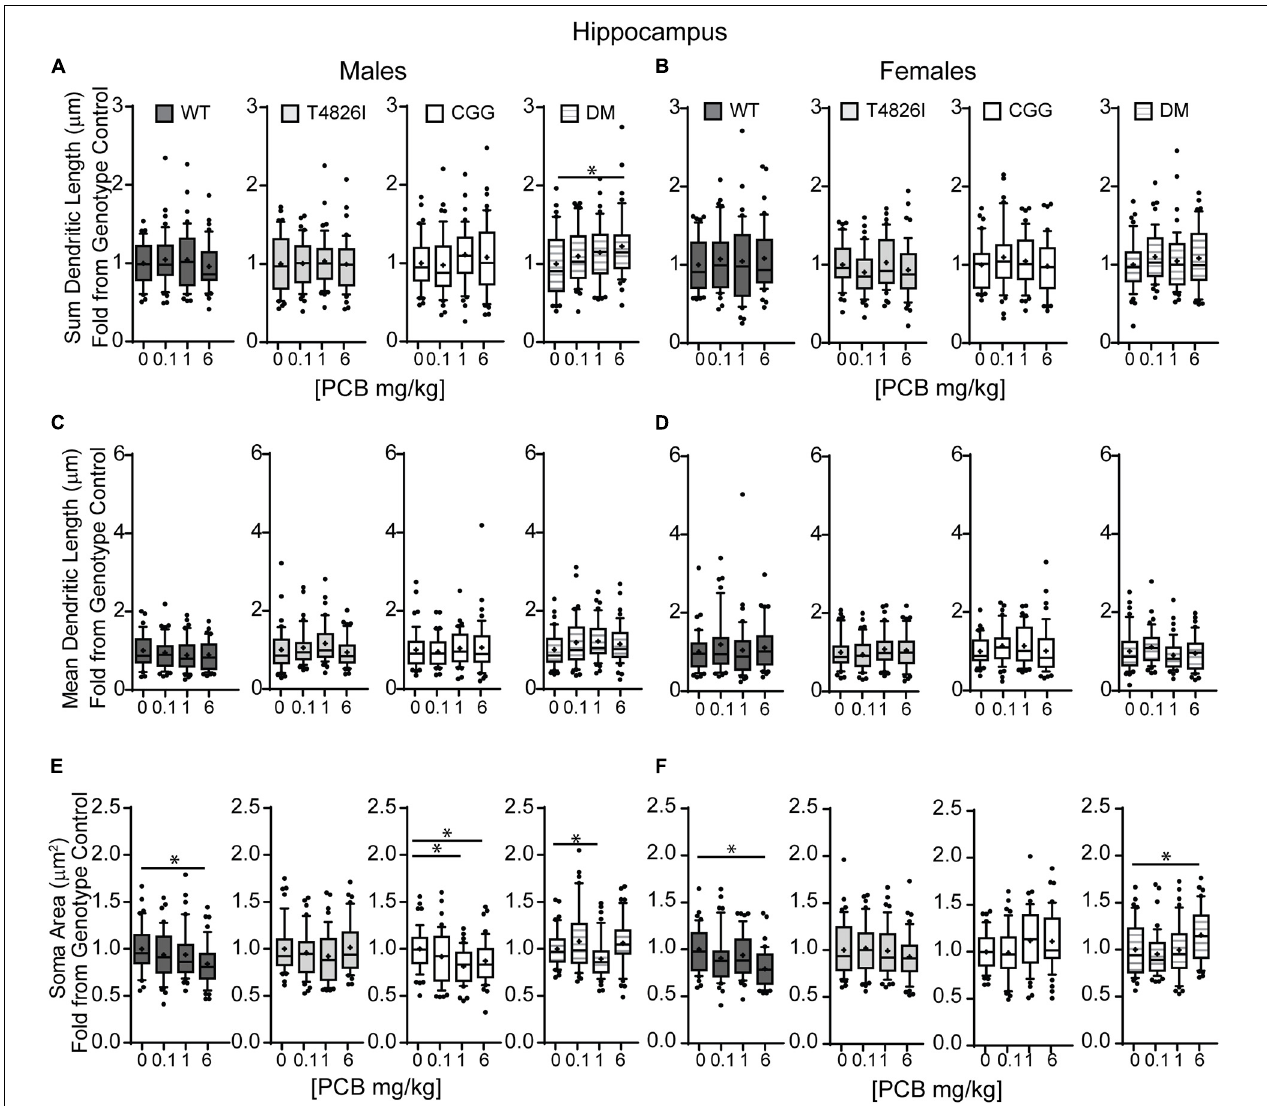
FIGURE 3 | Polychlorinated biphenyls effects on dendritic sum length are observed in DM male but not female mice and both genotype and PCB exposure impact soma area in both sexes. Dendritic morphology was assessed in basilar dendritic arbors of Golgi-stained pyramidal CA1 hippocampal neurons in P27–31 male and female WT, T4826I, CGG, or DM mice following gestational and lactational PCB exposure via the maternal diet. (A,B) Sum length of dendrites per neuron ( µ m). (C,D) Mean dendritic length per neuron ( µ m). (E,F) Cell body area per neuron ( µ m 2 ). Data ( N = 39–49 neurons from at least six independent mice per sex per genotype per dose) are presented as box plots, where the box indicates the lower (25th) to upper (75th) quartiles, the “+” indicates the mean, whiskers indicate the 10–90th percentile, and dots represent values outside the upper or lower fences. Bar and asterisk indicate a significant difference between groups as determined by Kruskal–Wallis test followed by Dunn’s multiple comparisons test, or (E-CGG) one-way ANOVA followed by Dunnett’s multiple comparisons test with p ≤ 0.05 considered statistically significant. Average values of vehicle controls for WT, T4826I, CGG, and DM, respectively, are (A) 898.8, 804.8, 833.2, 815.2 µ m; (B) 833.1, 903.0, 909.5, 801.5 µ m; (C) 256.4, 215.7, 236.5, 228.3 µ m; (D) 214.4, 244.9, 241.9, 245.9 µ m; (E) 283.2, 246.3, 284.5, 230.2 µ m 2 ; and (F) 305.9, 240.3, 253.5, 238.8 µ m 2